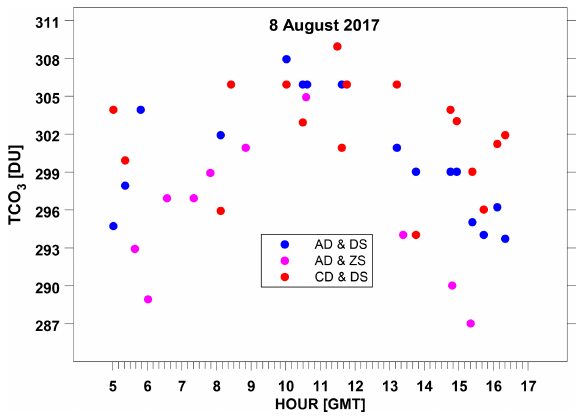
Figure 9. The Brewer-adjusted TCO 3 values measured at Belsk on 8 August 2017 with different settings of the Dobson spectropho- tometer.